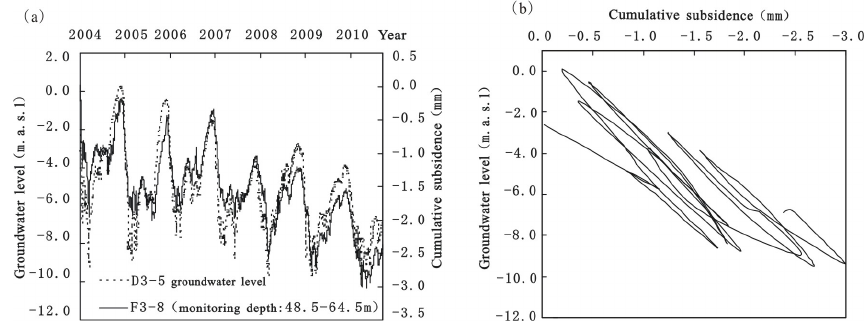
Figure 2. Deformation behavior of sand strata vs. its corresponding groundwater level at F3-8. (a) Groundwater level and deformation over time, (b) groundwater level vs. deformation hysteresis